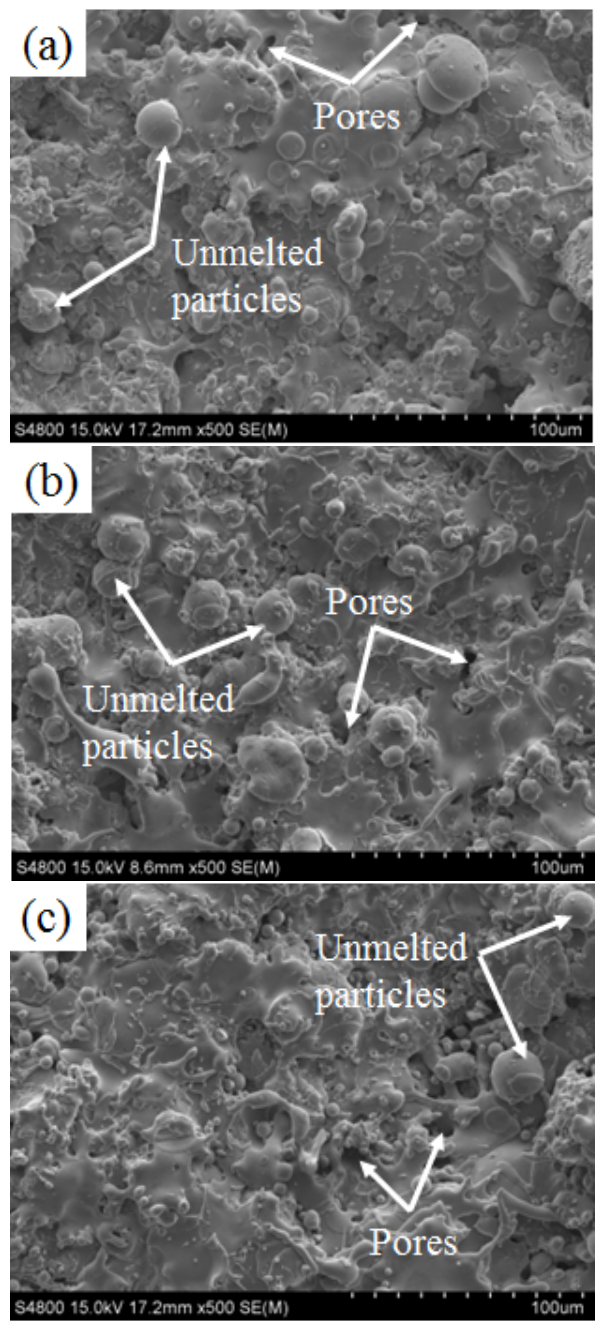
Figure 1: SEM images of surface of the amorphous coatings de- posited under different spraying power levels (a) 30kW, (b) 35kW and (c) 40kW,